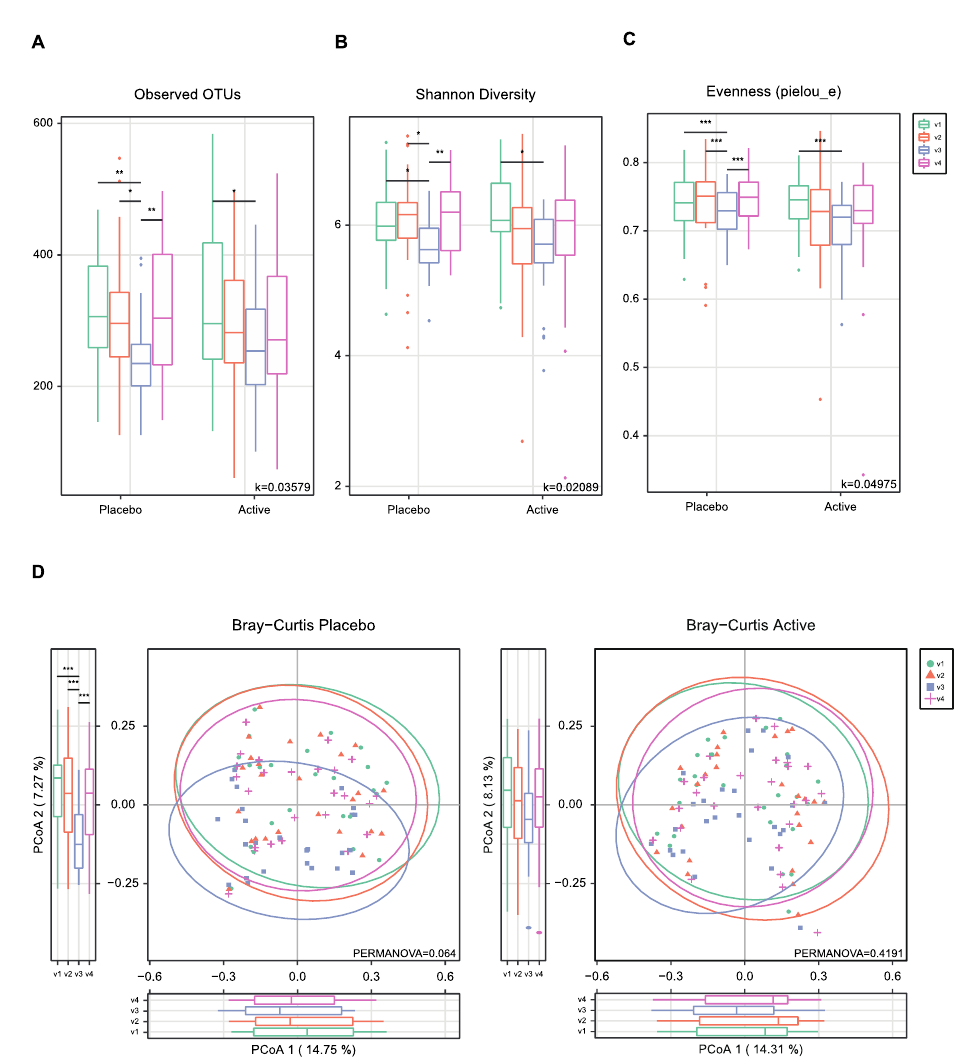
Figure 2. Alpha- and beta-diversity comparisons of the gut microbiomes of each group. ( A ) Boxplot of the Observed OTUs of each group. ( B ) Boxplot of the Shannon diversity of each group. ( C ) Boxplot of the Pielou’s evenness of each group. ( D ) Bray–Curtis distances within each group. The color of the boxplots and dots represents the different groups analyzed based on the legend (v1, visit1; v2, visit2; v3, visit3; v4, visit4). * p < 0.05, ** p < 0.01, *** p < 0.001 (Wilcoxon test). OTUs, operational taxonomic units.